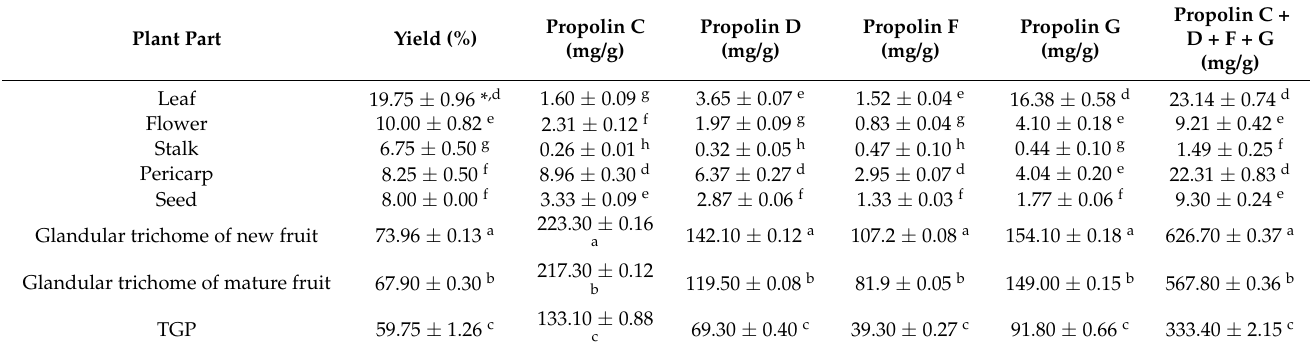
Table 1. Dry matter yield (%) and propolin content (mg/g) in different parts of M. tanarius